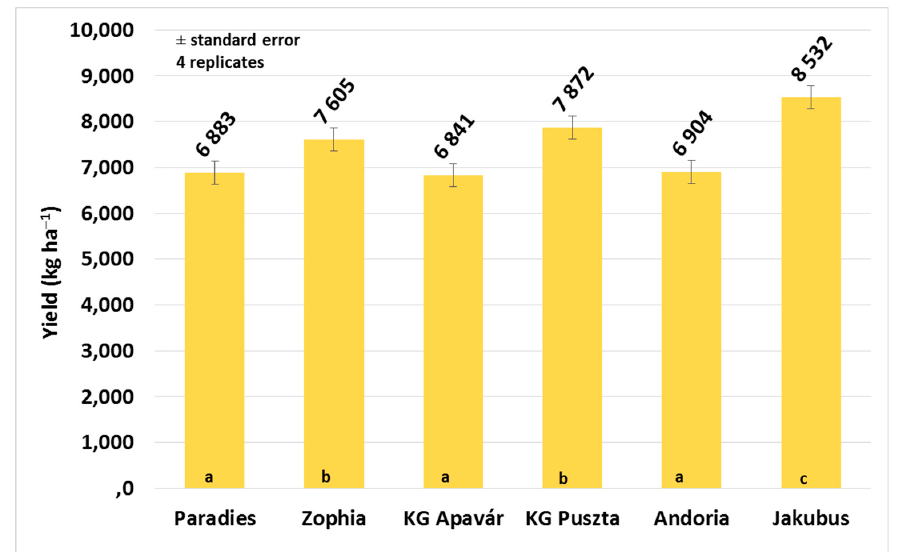
Figure 11. Grain yield of winter barley cultivars, average of N treatments (Debrecen, 2020). Standard error of means, 4 replicates. The differences in grain yields were statistically significant among the varieties. Different letters means statistically significant discrepancy between averages ( p < 0.05).